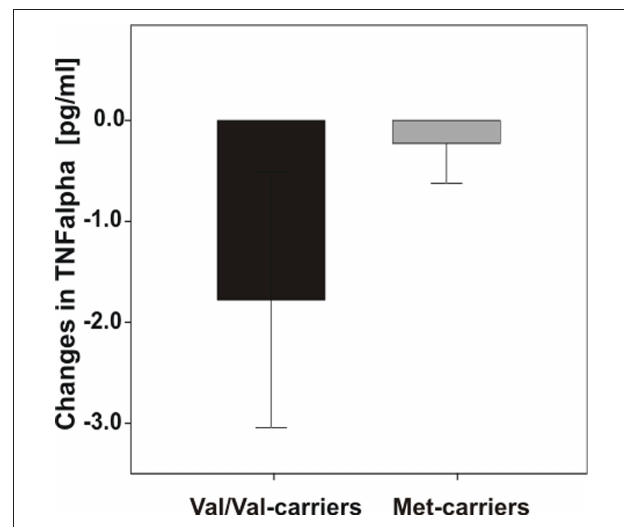
Figure 5 | Differences in TNF-alpha levels pre- vs. post-dietary intervention according to COMT val158Met genotype. Note that Val/ Val -carriers exhibited greater reductions of TNF-alpha than Met -carriers, however analysis failed to reach significance. Error bars indicate standard error